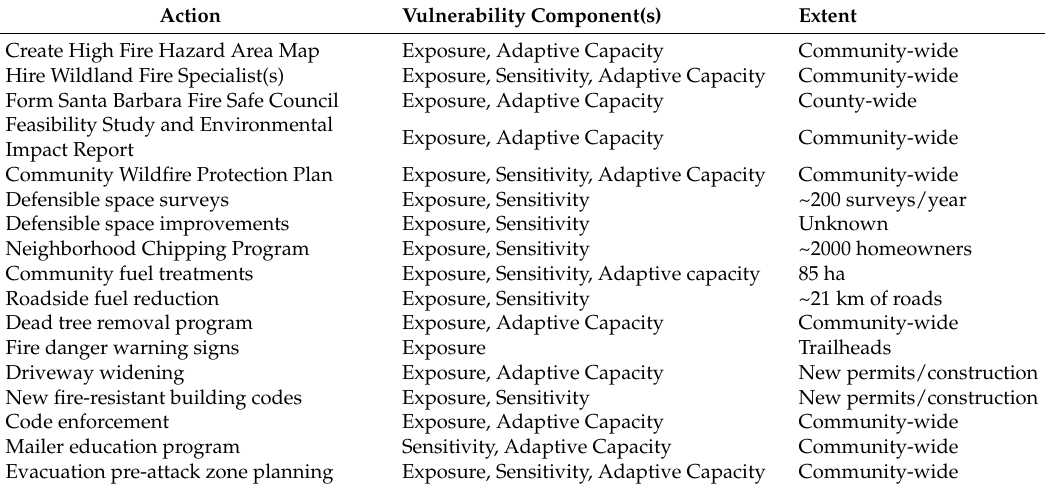
Table 1. Activities undertaken by Montecito Fire Protection District from 1998–2017 to reduce wildfire